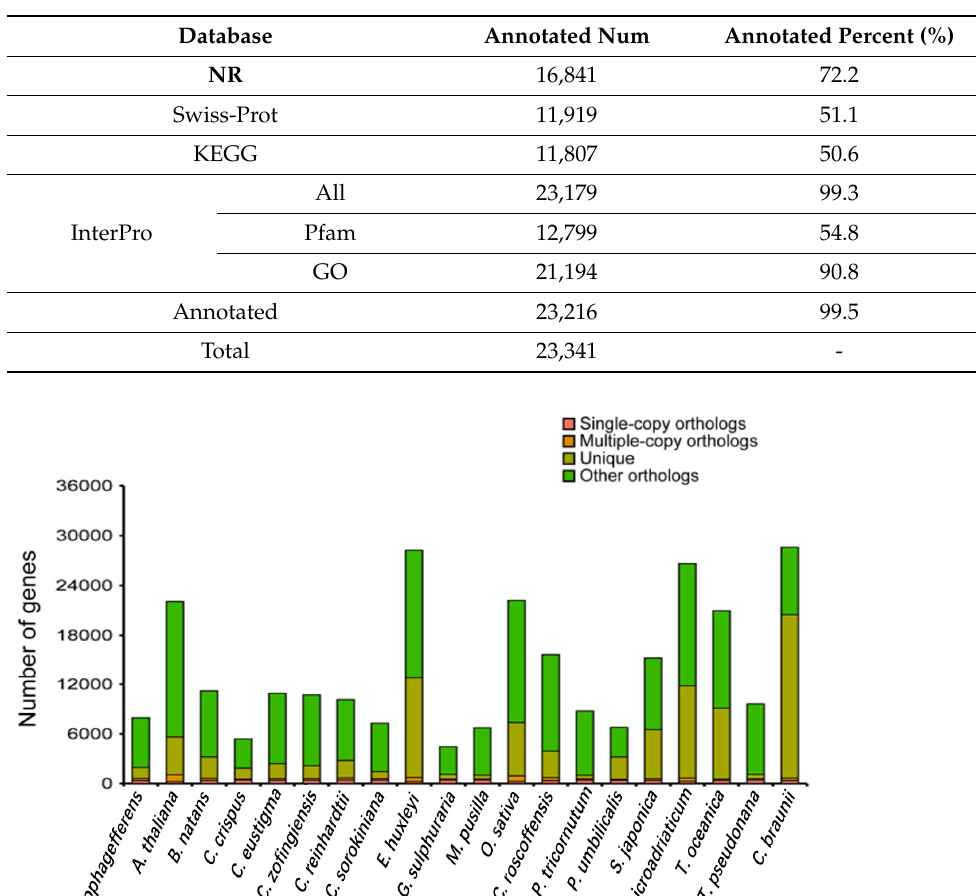
Figure 4. Common and unique gene families in five groups. Venn diagram showing comparison of shared and unique protein-coding genes among Chrysotila roscoffensis , Emiliania huxleyi , Thalassiosira pseudonana, Thalassiosira oceanica , and Saccharina japonica based on orthology analysis.